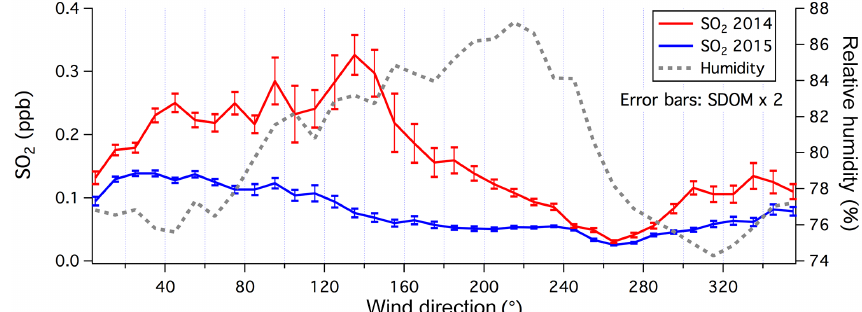
Figure 2. Averaged SO 2 mixing ratio and relative humidity vs. wind direction for year 2014 and 2015. Error bars on SO 2 indicate 2 standard errors. Elevated humidity marks the marine-influenced wind sector to be between about 60 and 260 ◦ . Higher and more variable SO 2 mixing ratios were observed from the southeast, particularly in 2014. Icelandic volcano plumes (e.g., Fig. A1) were excluded from averaging.